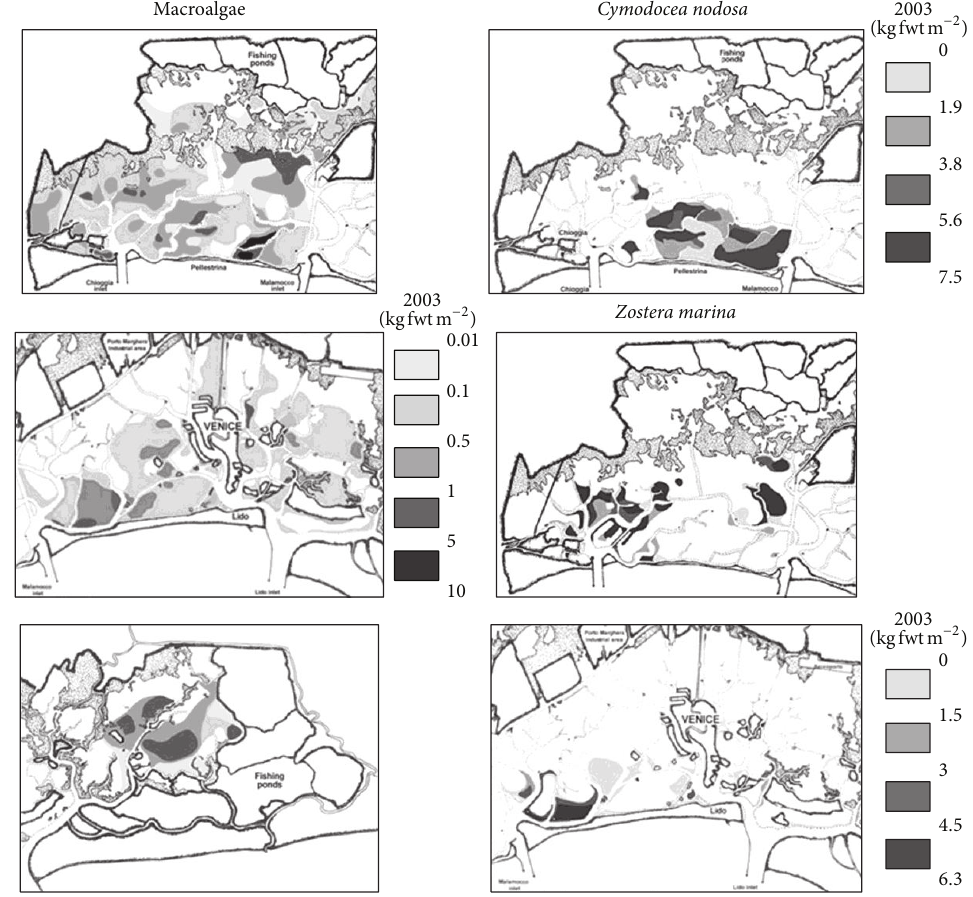
Figure 7: Macrophyte biomass distribution in 2003. Modified from